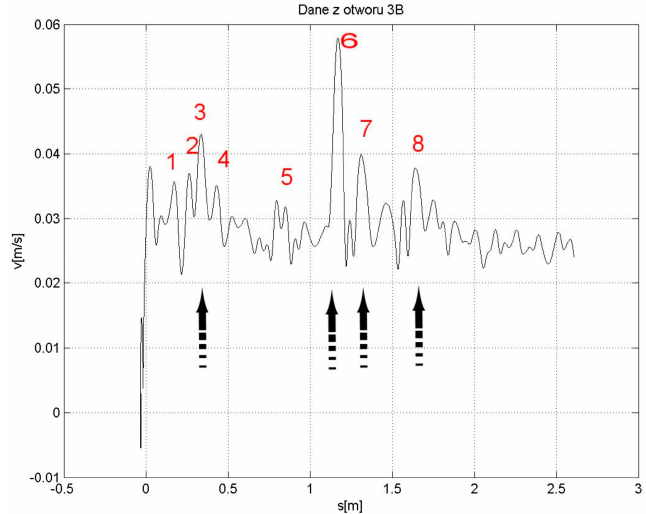
Figure 1. Drilling speed as a function of depth,